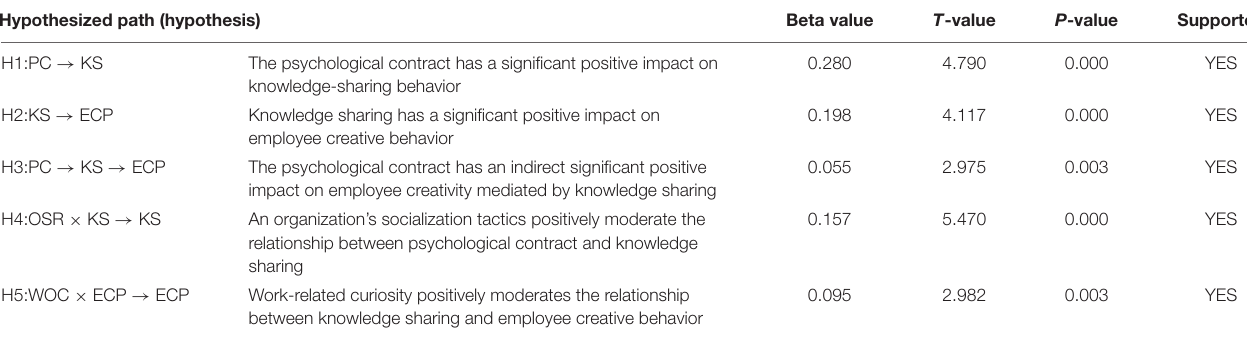
TABLE 6 | Hypotheses